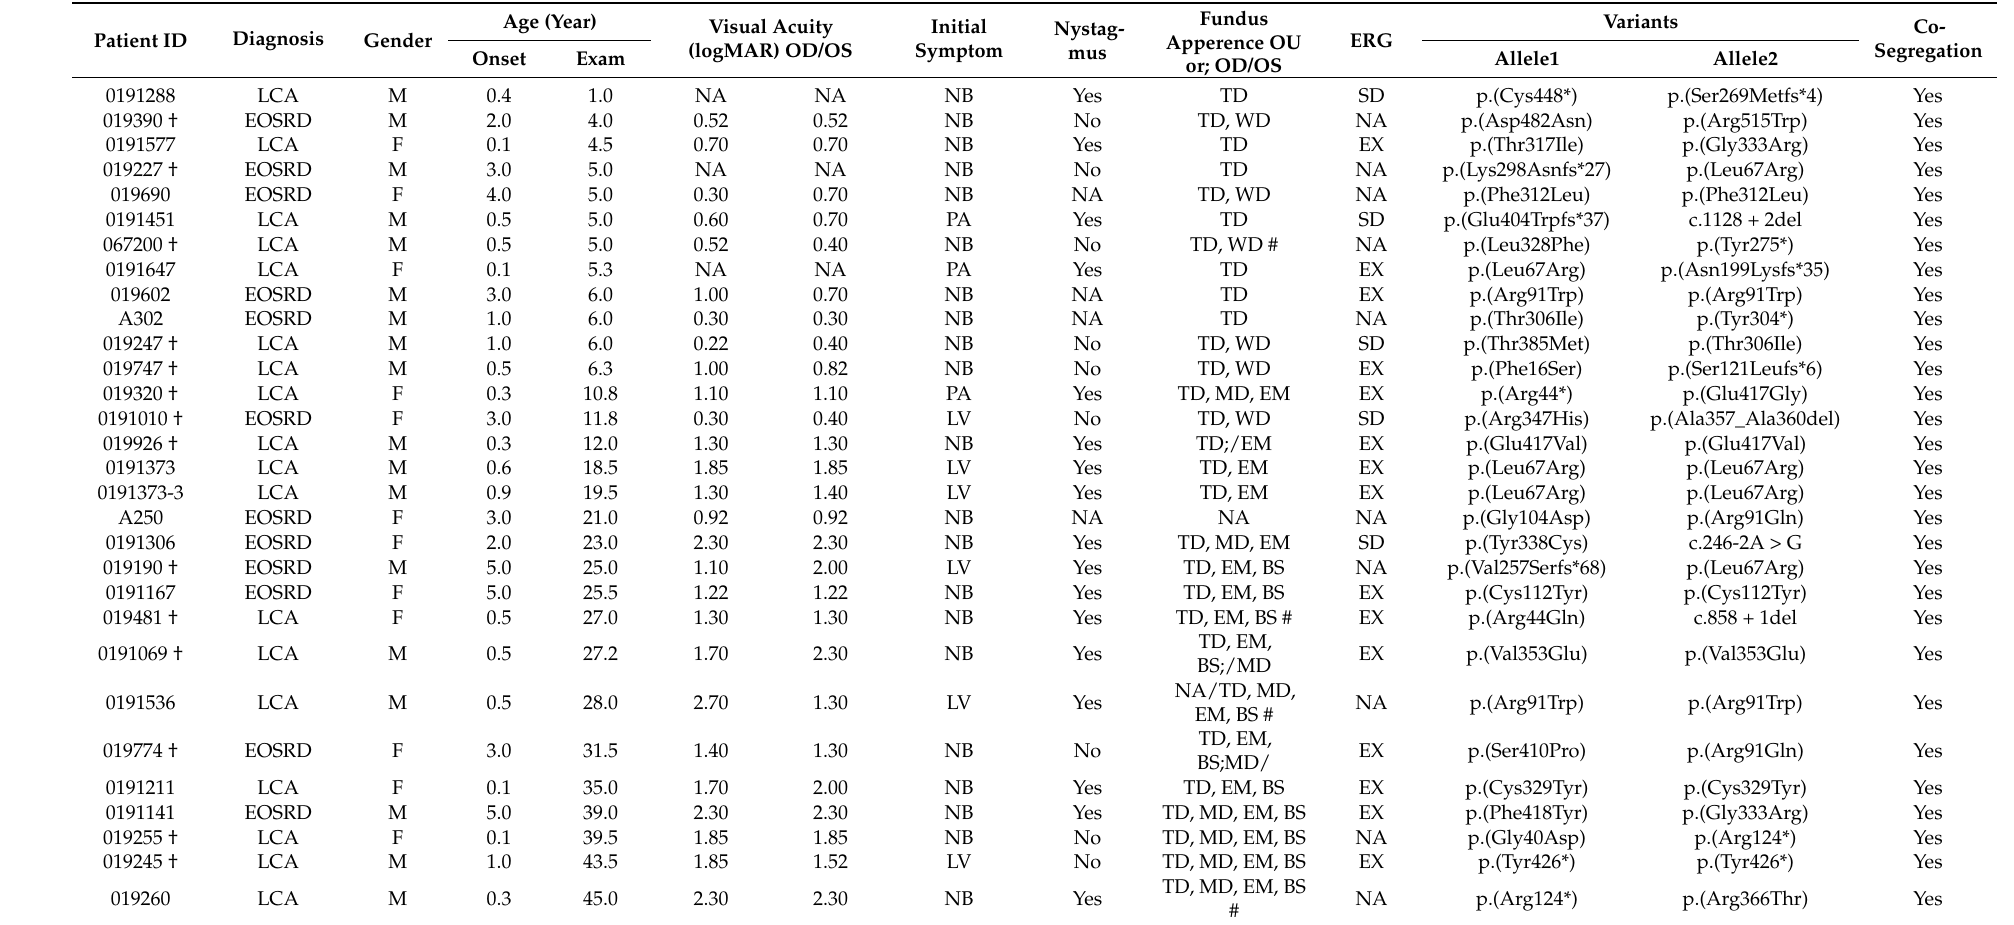
Table 1. The clinical features and results of the RPE65 gene variant screening of the